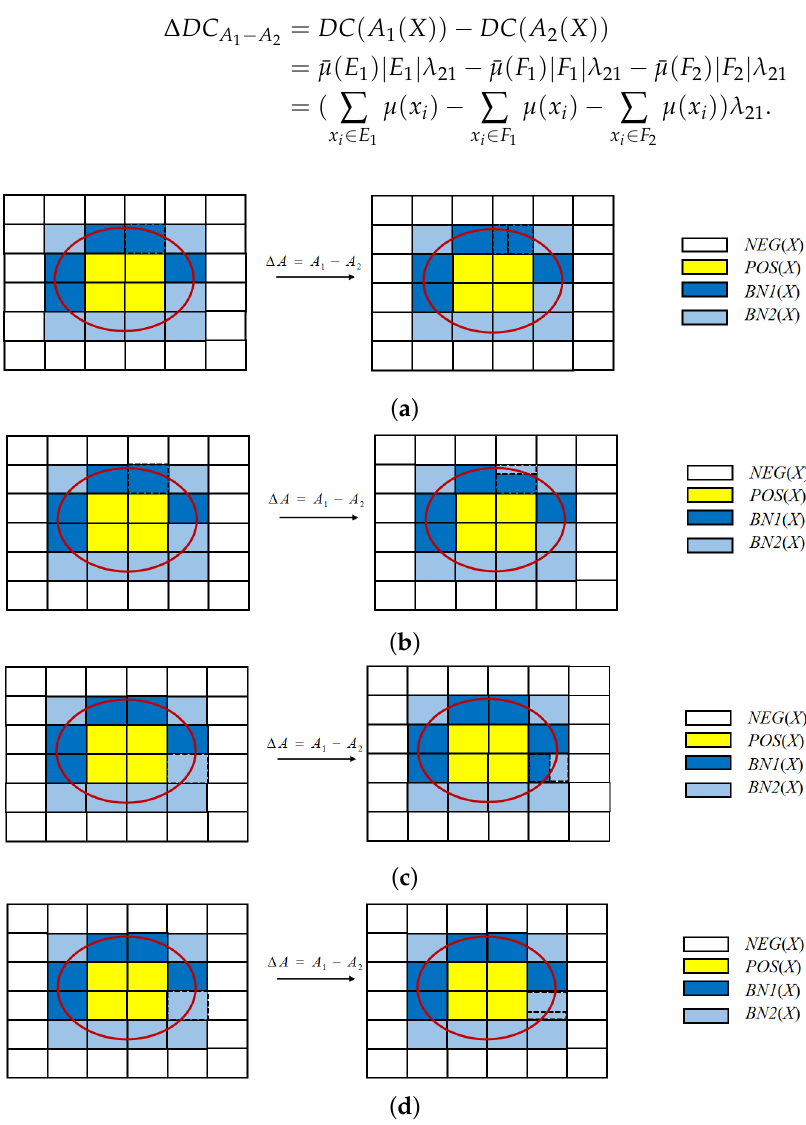
Figure 2. The granules subdivided in BN 1 ( X ) and BN 2 ( X ) of the cost-sensitive approximation model of rough sets. And all the red circles in the figure represent the set X . In addition, ( a ) shows the case 1 in which the granules are subdivided in BN 1 ( X ) ; ( b ) shows the case 2 in which the granules are subdivided in BN 1 ( X ) ; ( c ) shows the case 1 in which the granules are subdivided in BN 2 ( X ) ; ( d ) shows the case 2 in which the granules are subdivided in BN 2 ( X )